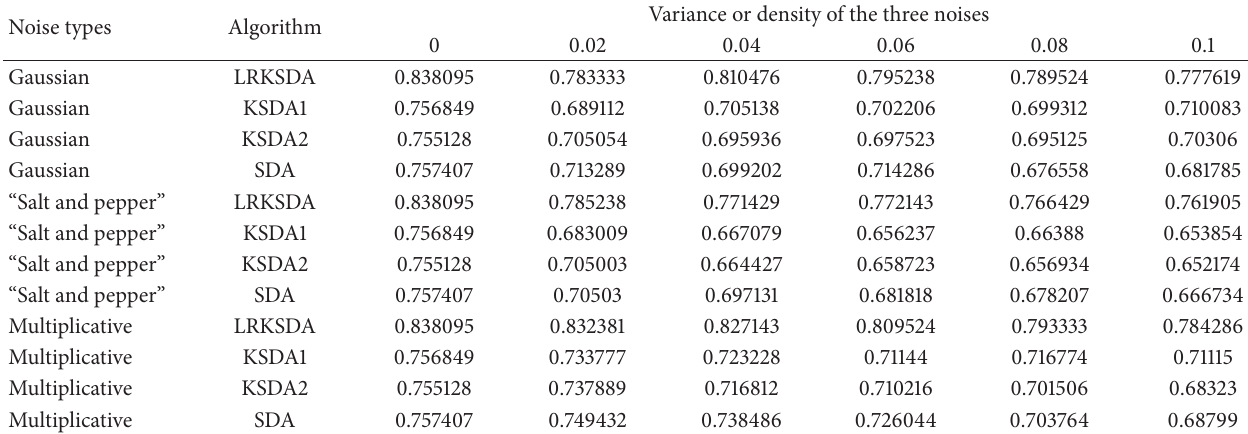
Table 5: Classification accuracy of different graphs with varying noise on Musk